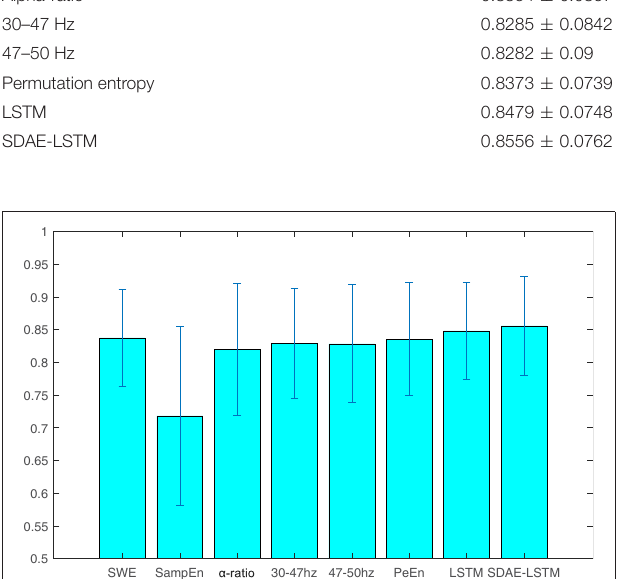
FIGURE 8 | The average and standard deviation of the P k values of wavelet entropy, sample entropy, alpha-ratio, the average spectra of 30–47 and 47–50 Hz, permutation entropy, LSTM, and SDAE-LSTM, respectively. The blue lines in the figure represent the variance, and the blue rectangles represent the average